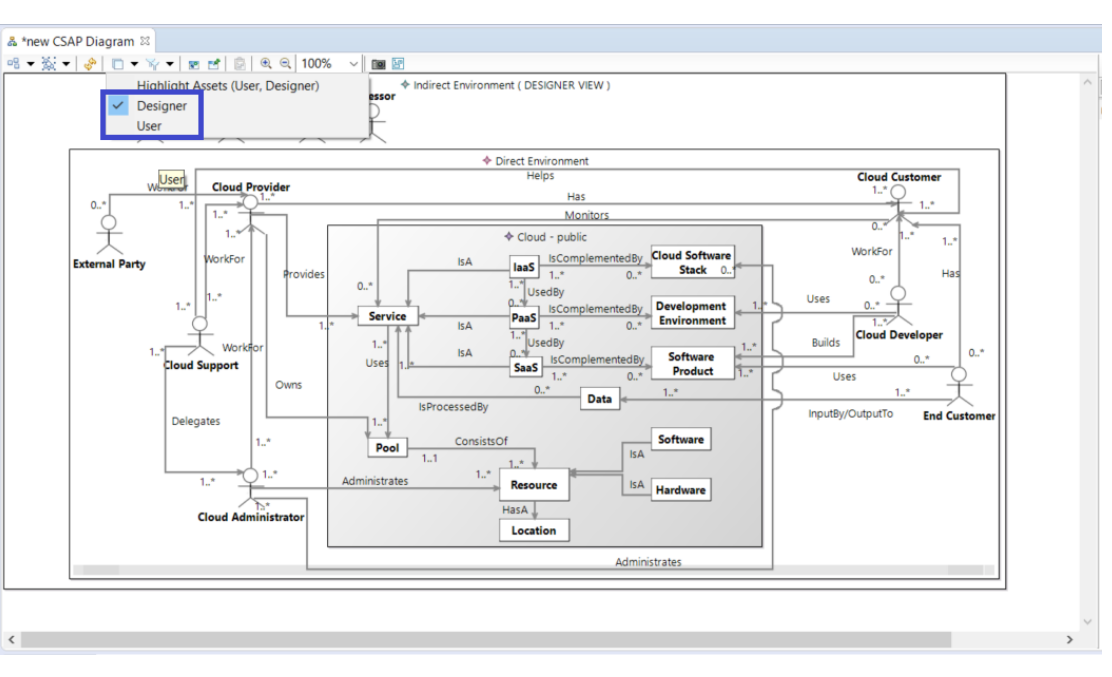
Figure 6. Editor mode of the CSAP